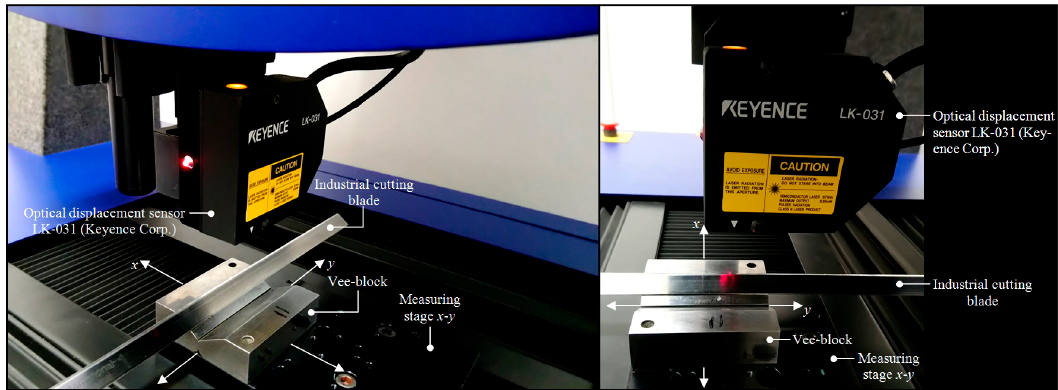
Figure 7. Multisensory optical profilometer Taylor-Hobson Talysurf CLI 2000 during measurements of low-stiffness planar industrial cutting blade (sample B1-7).